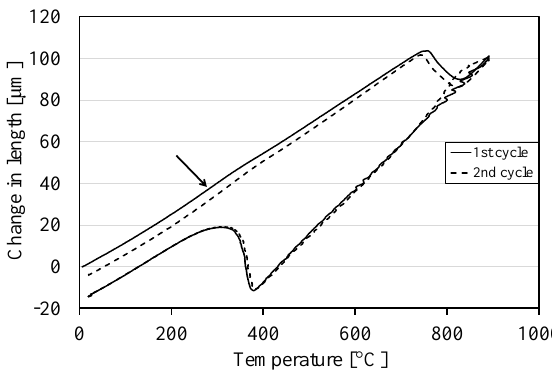
Figure 10. Dilatometry curves for a sample heat-treated in two cycles.